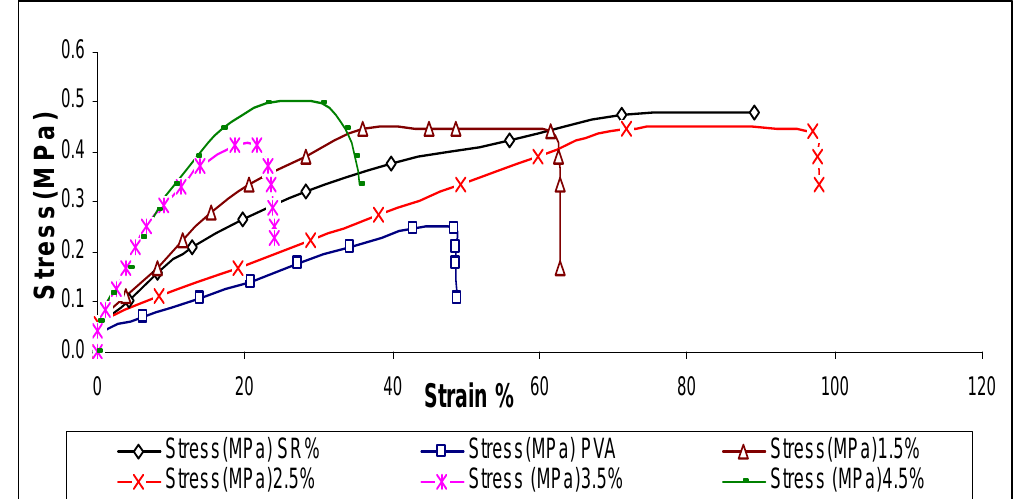
Fig. 4: Stress-strain curves of sponge rubber samples.